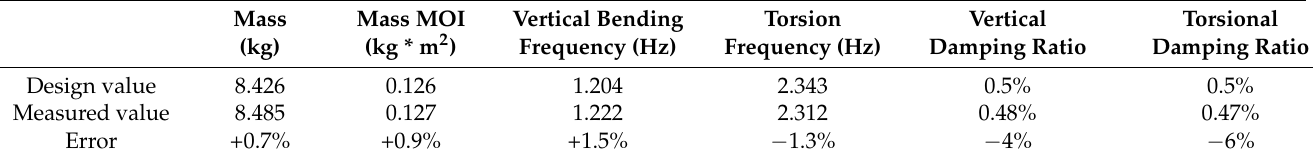
Table 4. Design and measured parameters of flutter wind tunnel test